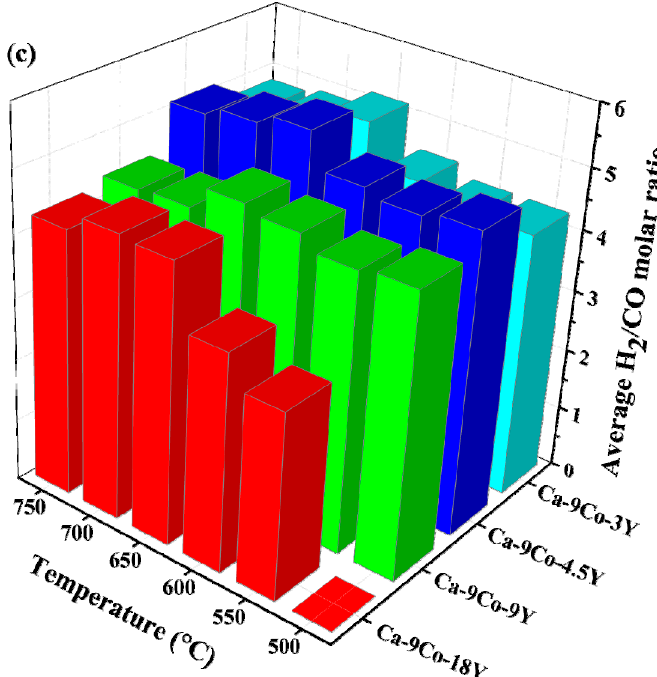
Figure 7. Effect of reaction temperature and yttrium loading on: ( a ) methane conversion; ( b ) hydrogen yield; and ( c ) H 2 /CO molar ratio, at S/C = 2.